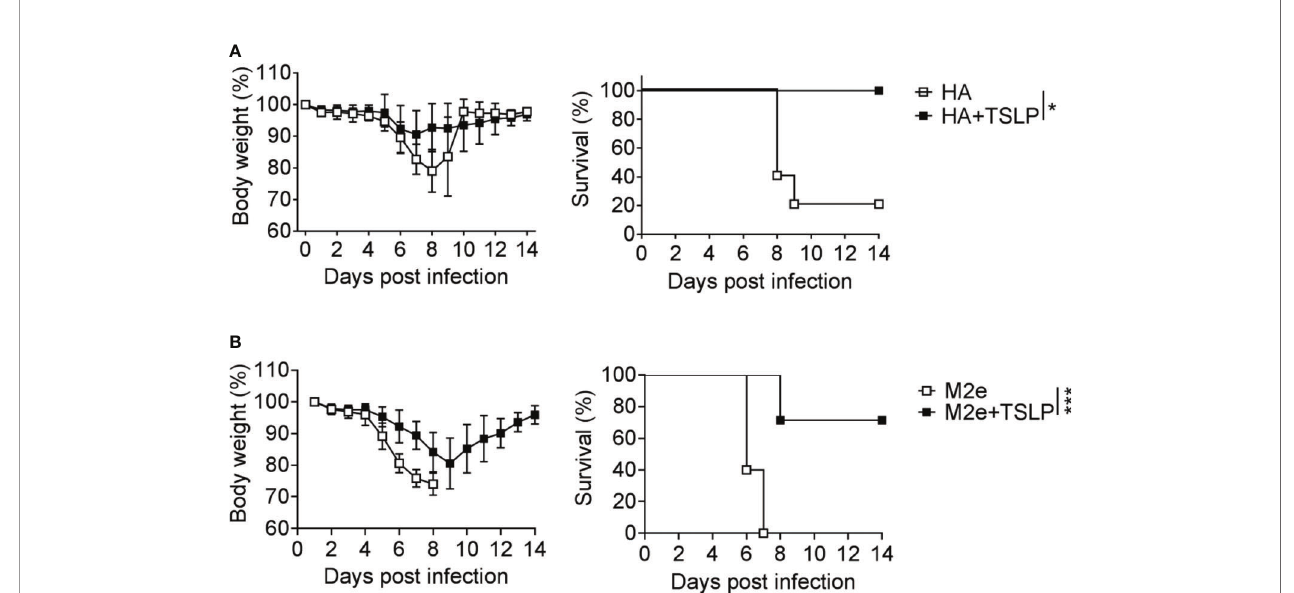
FIGURE 1 | TSLP boosts ef fi cacy of in fl uenza vaccines administered by the intranasal route. (A) B6-WT mice (n = 5-6 per group) were immunized by intranasal application of the In fl usplit Tetra ® vaccine (HA) in the presence or absence of 1 m g TSLP. Three weeks after the third booster immunization, mice were challenged with 3×10 3 PFU of in fl uenza A virus PR8 strain. Weight loss and survival were monitored daily for 14 days. (B) B6-WT mice (n = 5-7 per group) were intranasally immunized with the CTA1-3M2e-DD (M2e) vaccine in the presence or absence of 1 m g TSLP. Five weeks after a single booster immunization, mice were challenged with 50 PFU of in fl uenza A virus PR8 strain. Weight loss and survival were monitored daily for 14 days. Mice were sacri fi ced as soon as they lost 25% of their original body weight. Data are shown as mean ± SD. *P < 0.05, ***P < 0.001, by log-rank test. Data are representative of two independent